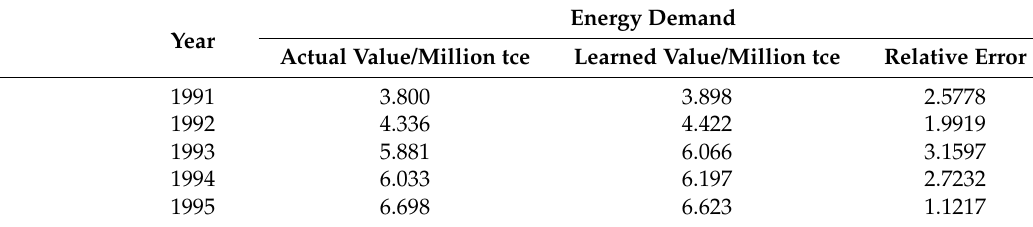
Table A2. Training and test data for energy demand in